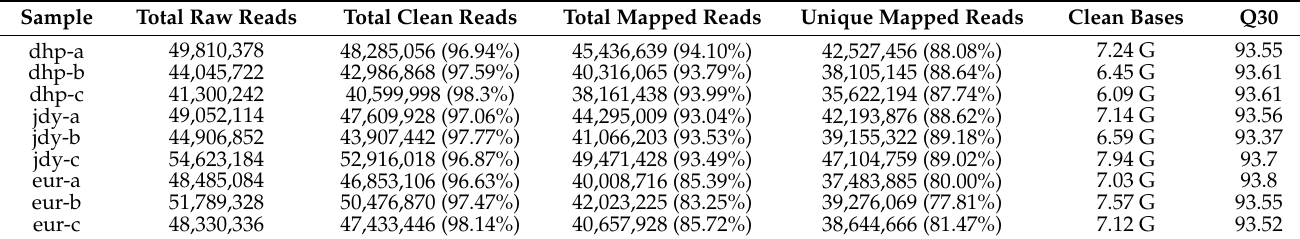
Table 1. Statistical results of the RNA-Seq data.